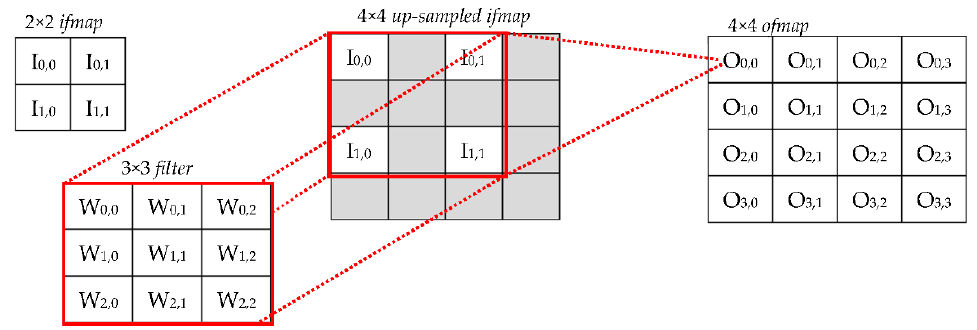
Figure 1. An example of the operations performed by a TCONV to process a 2 × 2 ifmap with a 3 × 3 filter when S D = 2.